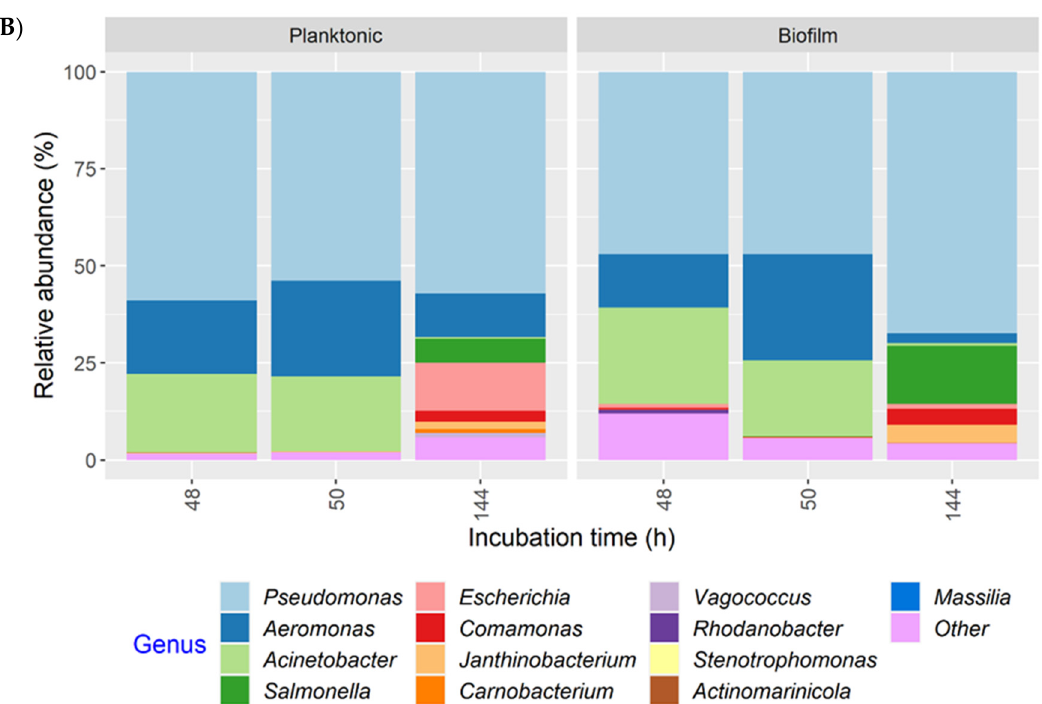
Figure 7. Relative abundance of bacterial genera in planktonic cultures and biofilms, as determined by 16S rRNA gene amplicon sequence analysis. The multispecies cultures were developed with meat processing surface bacteria (MPB), Salmonella Typhimurium, and Escherichia coli O157:H7 at 15 ◦ C for six days, with the pathogens introduced simultaneously with MPB ( A ) or delayed by 48 h ( B ). Genera with a relative abundance <1% in any of the samples were classified as “Other”.